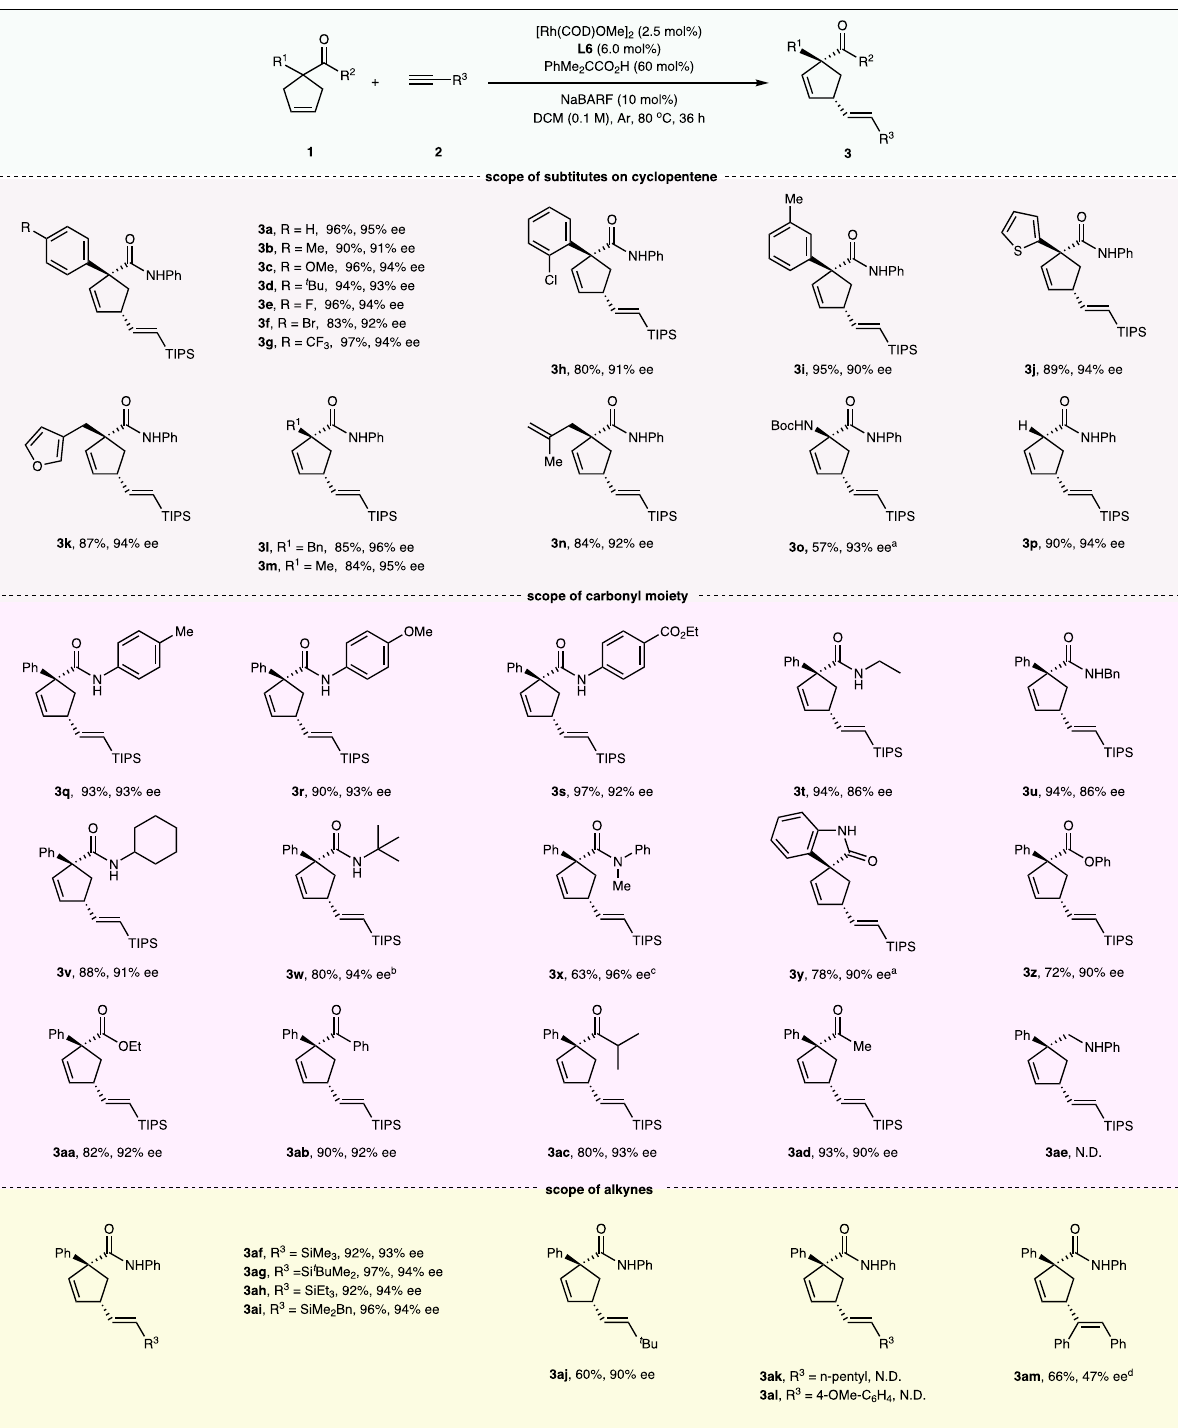
ef fi ciency and atom-economy. Further studies on the reaction mechanism and expansion of the asymmetric intermolecular Alder-ene type reactions are underway in our laboratory.